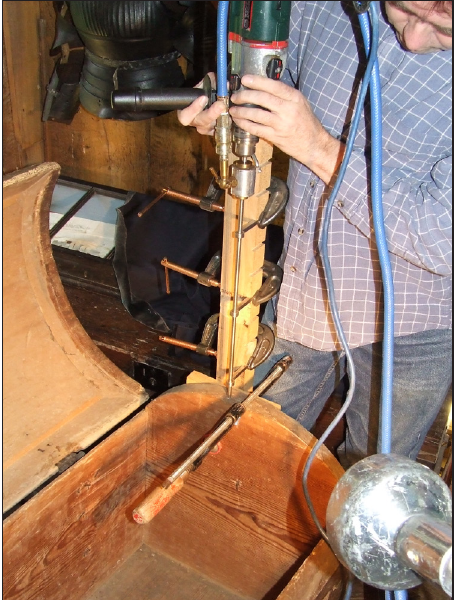
Figure 1: One of the fifteenth century pine chests in Mendlesham church being sampled for dendrochronology by Dan Miles (photo by